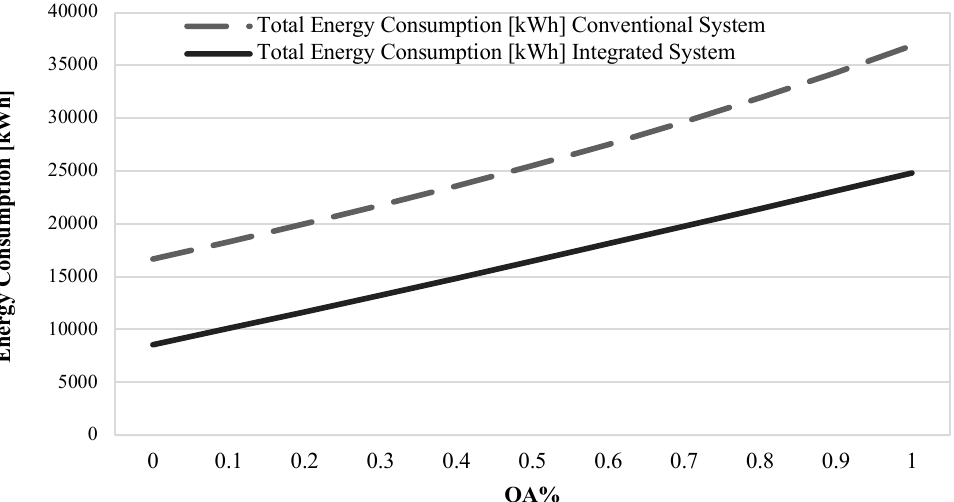
Figure 3. Total annual energy consumption [kWh]